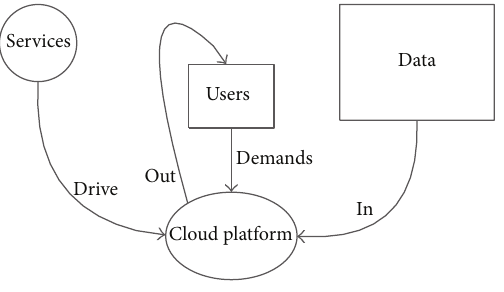
Figure 1: Services architecture in mobile Internet.